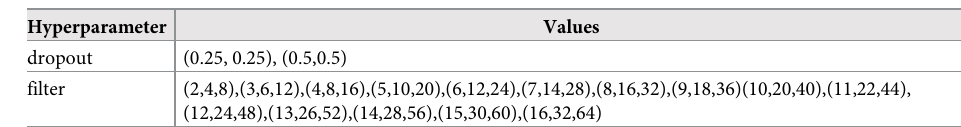
Table 3. CNN characteristics.